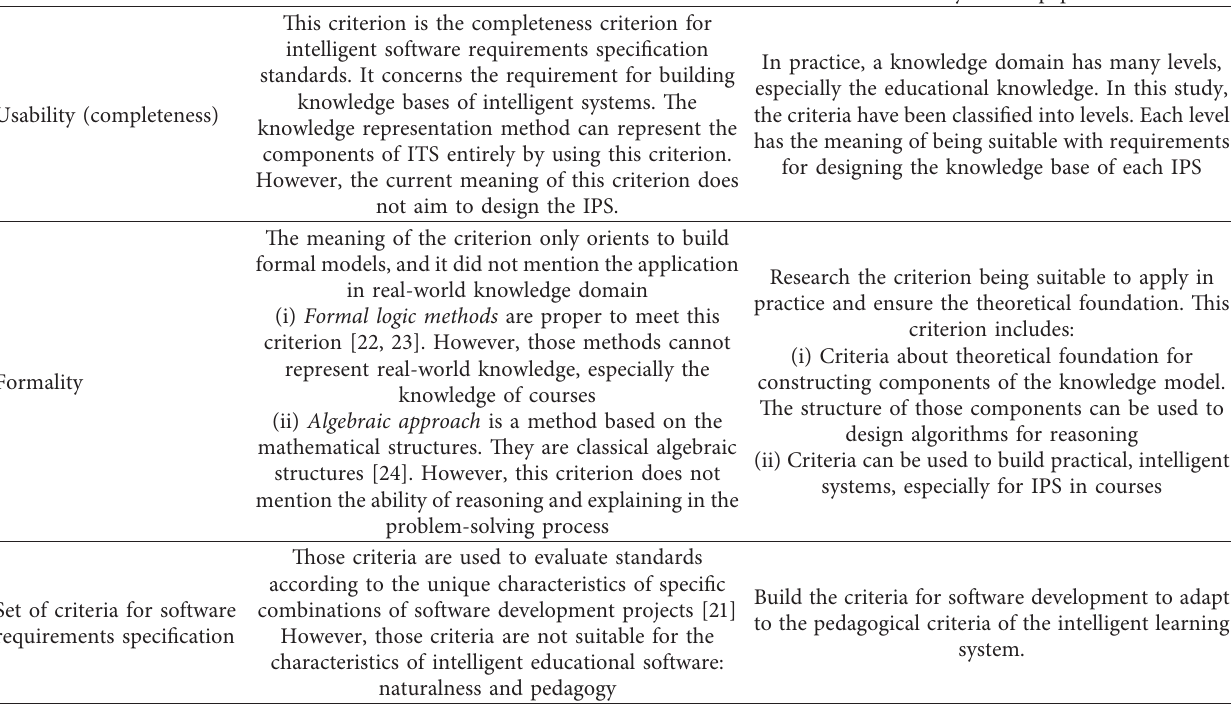
Table 1: Current criteria of knowledge representation for IPS.